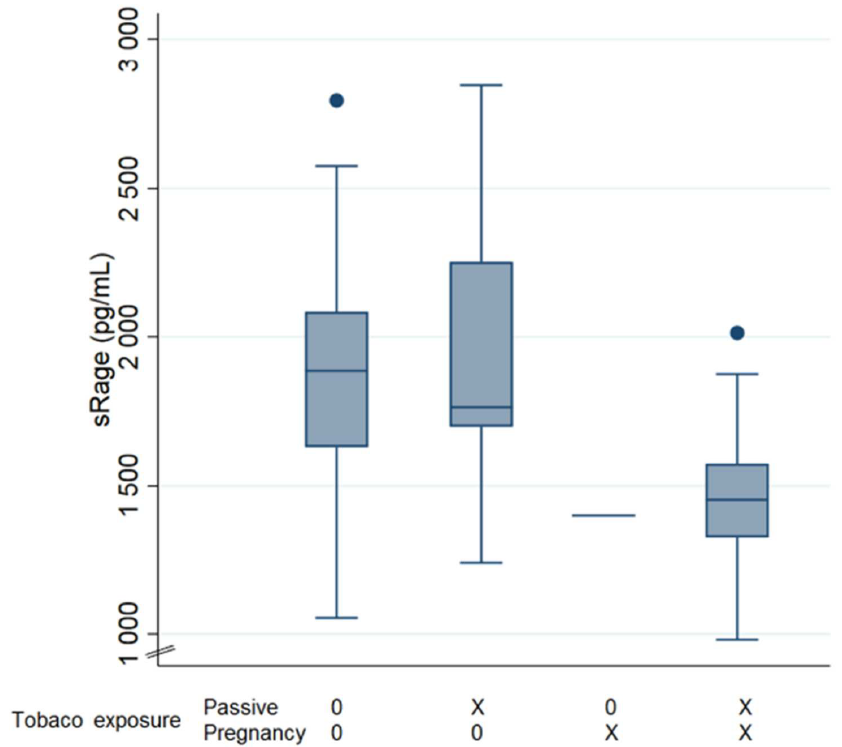
Figure 2. sRAGE level according to tobacco exposure. sRAGE level in pg/mL. 0: no tobacco, x: tobacco.